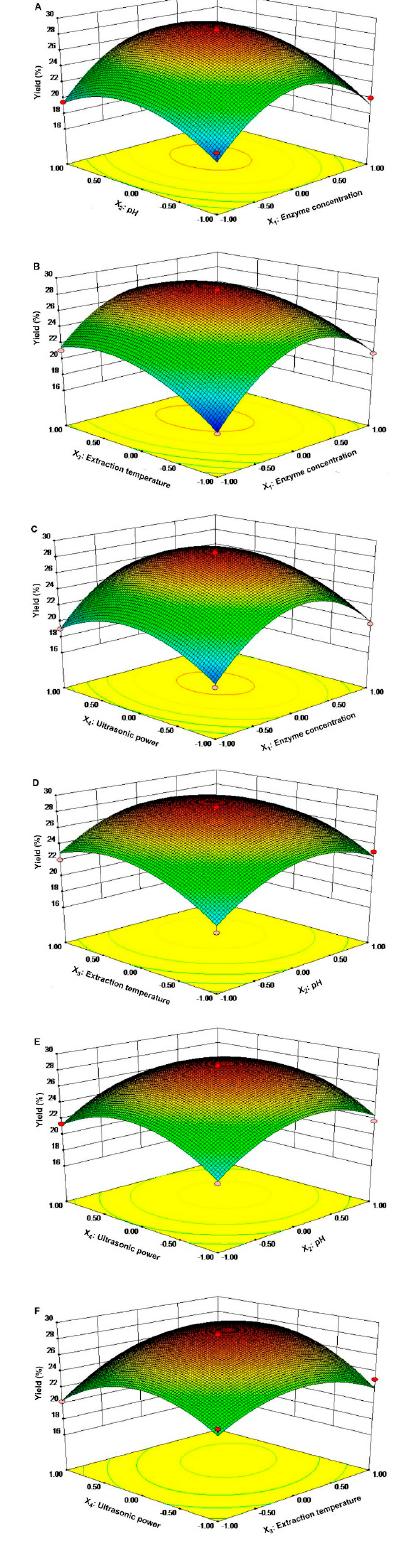
Fig. 3: Response surface analysis for TPs yield from green tea with ultrasonic- assisted compound enzymatic extraction with respect to enzyme concentration and pH (A); enzyme concentration and extraction tem- perature (B); enzyme concentration and ultrasonic power (C); pH and extraction temperature (D); pH and ultrasonic power (E); extraction temperature and ultrasonic power